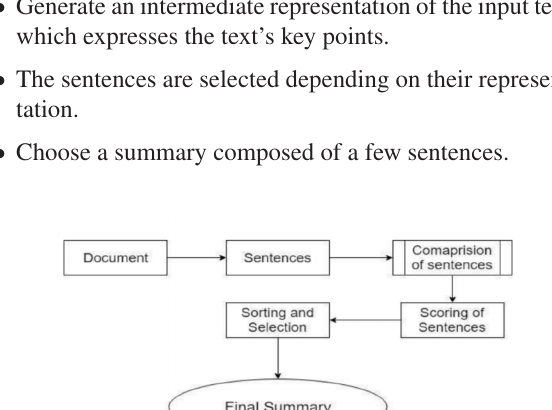
Figure 1. Adjacency Matrix